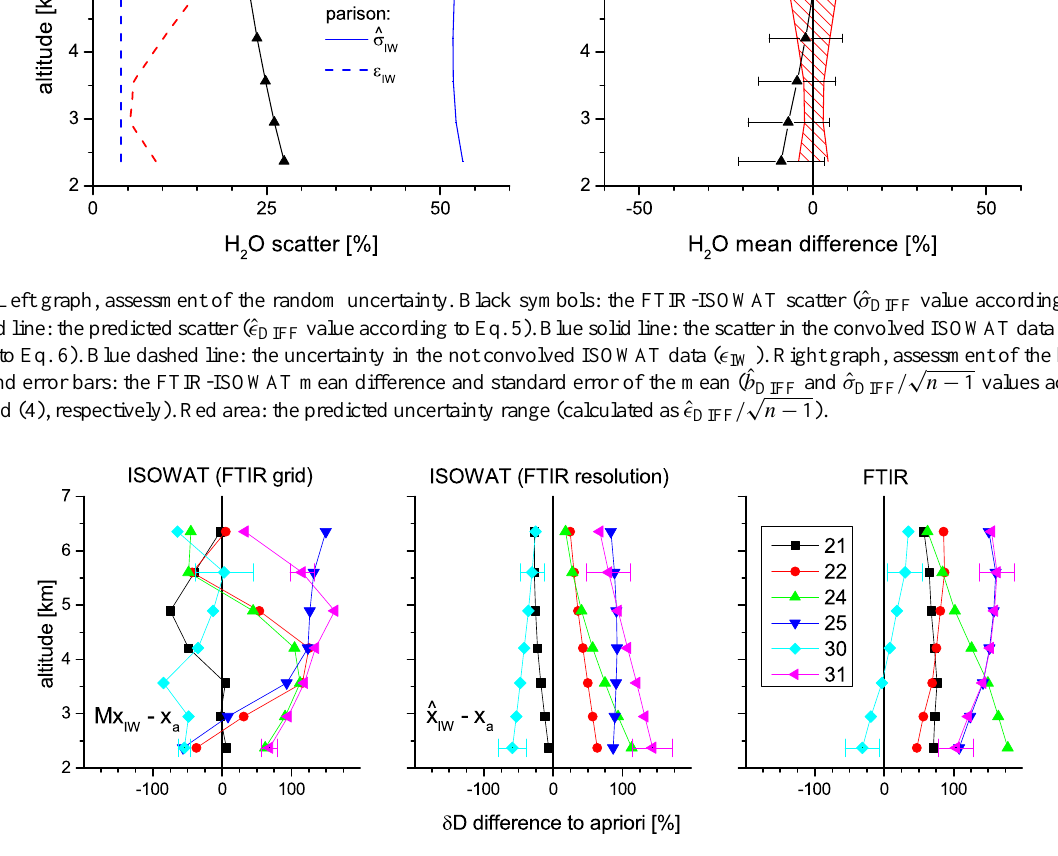
Figure 8. As Fig. 6, but for δ D. Here the error bars are clearly